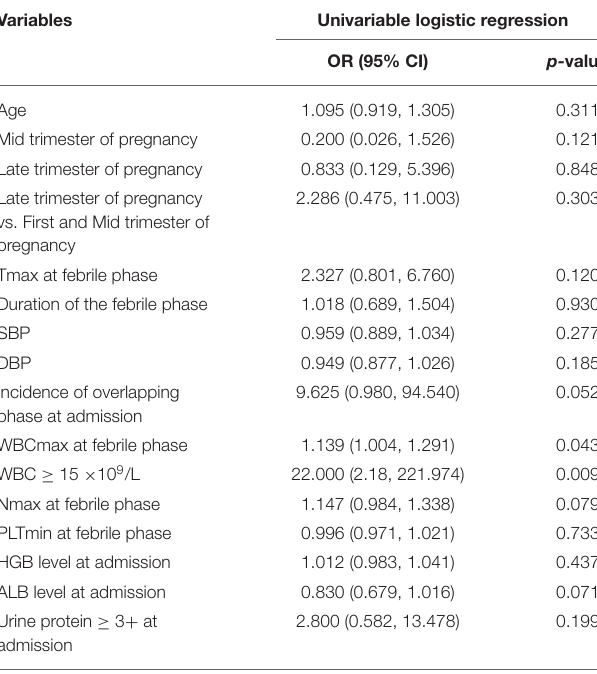
HFRS, Hemorrhagic fever with renal syndrome; T, temperature; SBP, systolic blood pressure; DPB, diastolic blood pressure; WBC, white blood cell; N, neutrophile; PLT, platelet; HGB, hemoglobin; ALB, albumin.